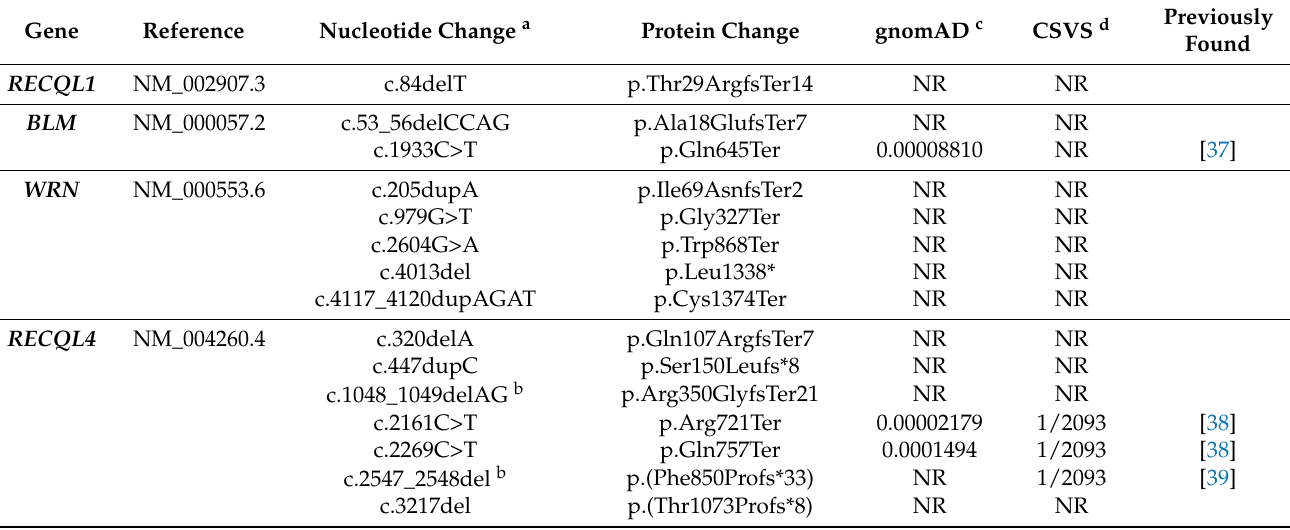
Table 1. Pathogenic or likely pathogenic variants found in the RECQL1 , BLM , WRN , and RECQL4 genes in the 1993 cases